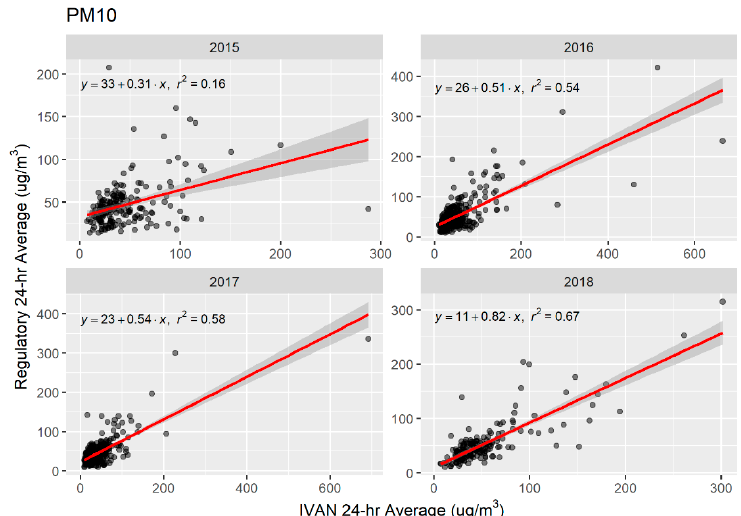
Figure 3. Scatter plots of average 24-h measurements of PM 10 , Imperial Community Air Monitoring Network and regulatory monitors, 2015–2018, by year. OLS simple linear regression lines shown in red with 95% confidence intervals (grey band). Table 3. Bootstrapped estimates of associations between Network and regulatory mean 24-h average PM 2.5 and PM 10 measurements from ordinary least squares linear regressions.